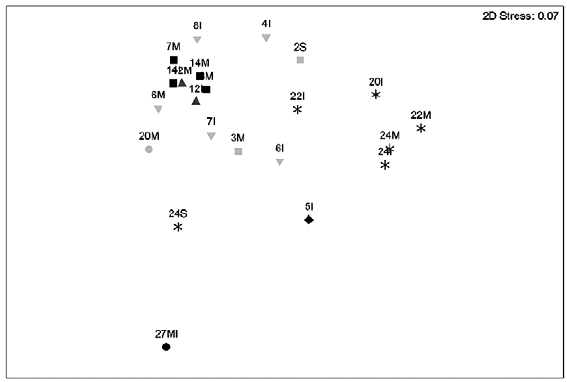
Fig. 4. – MDS plot based on qualitative samples. Labels include the site number (see Table 1) and the littoral level (S, supralittoral; M, mediolittoral; I, infralittoral). Sediment types (see Table 3 for codes) are plotted as follows: C, rhombus; CG, bright triangle; G, dark triangle; CoSG, dark quadrat; MeS, bright circle; FiS, asterisk; CC, dark circle; PO, bright